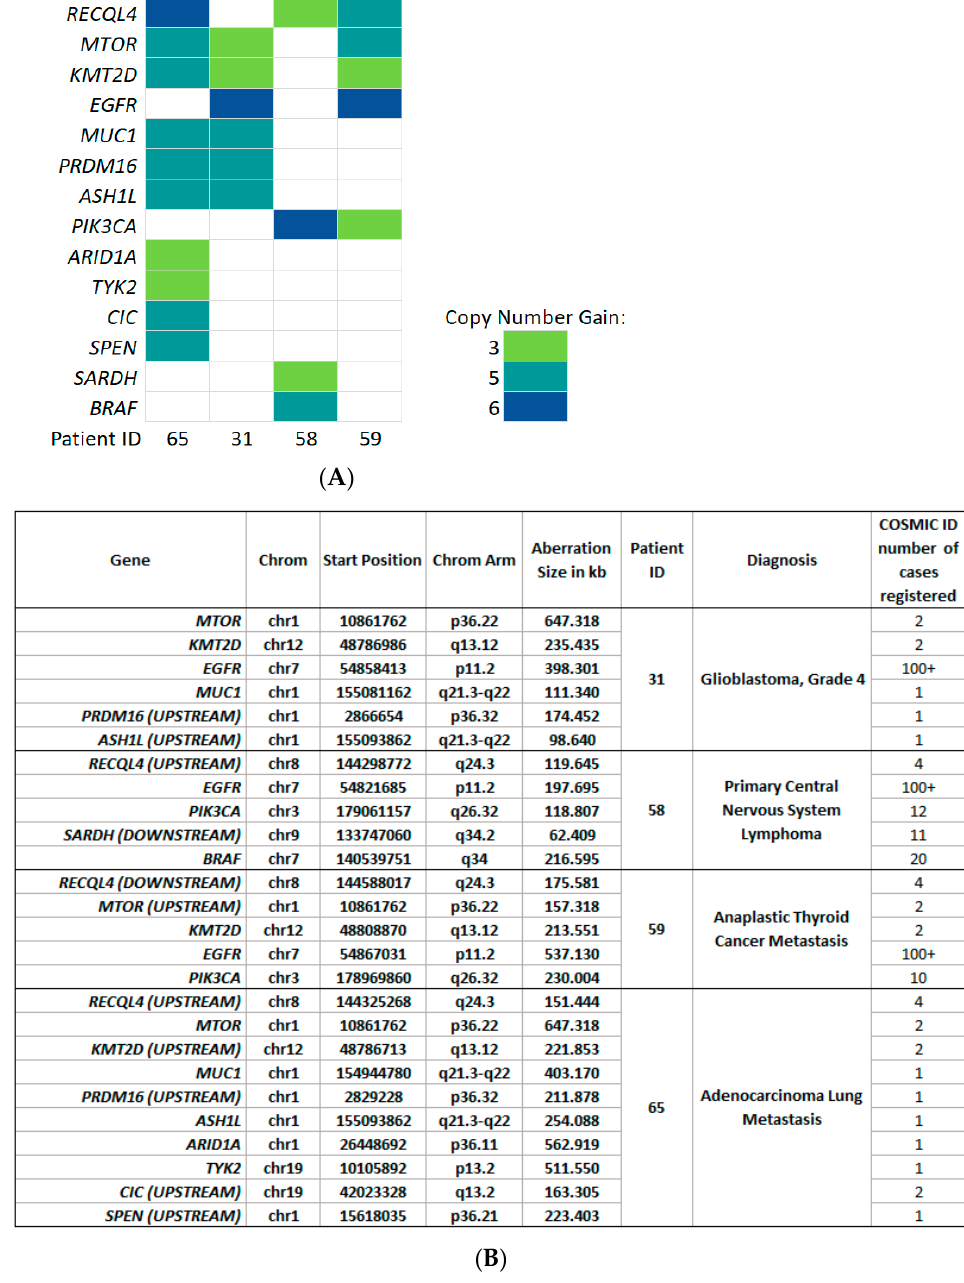
Figure 8. COSMIC registered copy number alterations detected in ccfDNA, but not gDNA of 4 brain tumor patients. ( A ) Graphical representation summarizing copy-number gain found in ccfDNA versus gDNA. Amplifications are shown in various colors to mark a copy number gains. ( B ) Detailed description of identified copy number gains.